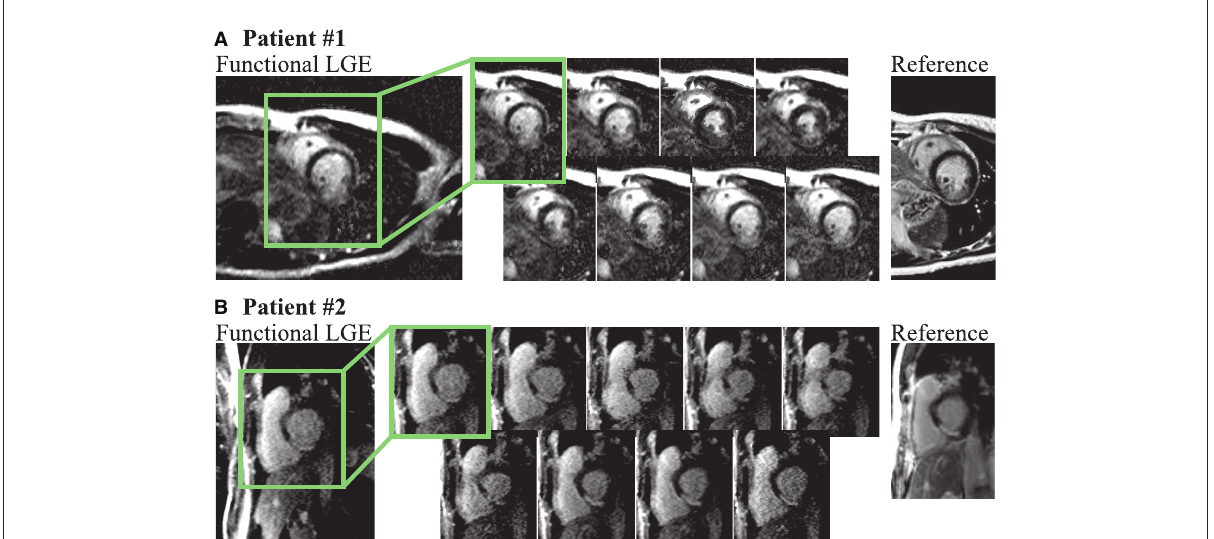
FIGURE6 (A) Functional LGE images acquired in a 41 year old female patient with known history of CAD and myocarditis in comparison to a reference LGE acquisition (heart rate 80 bpm, acquisition phases 8). The patient displays a large antero-lateral scar that is visible with the proposed technique throughout all cardiac phases. Retrospective choice of the inversion time enables bright scar hyper-enhancement delineated against the remote myocardium. However, compared to the reference scan, decreased imaging resolution hampers depiction of the scar structure. (B) Functional LGE images acquired in a patient suffering from CAD and displaying scar in the lateral segment (heart rate 72 bpm, acquisition phases 9). Clear depiction of the scar tissue is achieved in all cardiac phases, albeit at higher noise levels compared with the clinical reference scan.